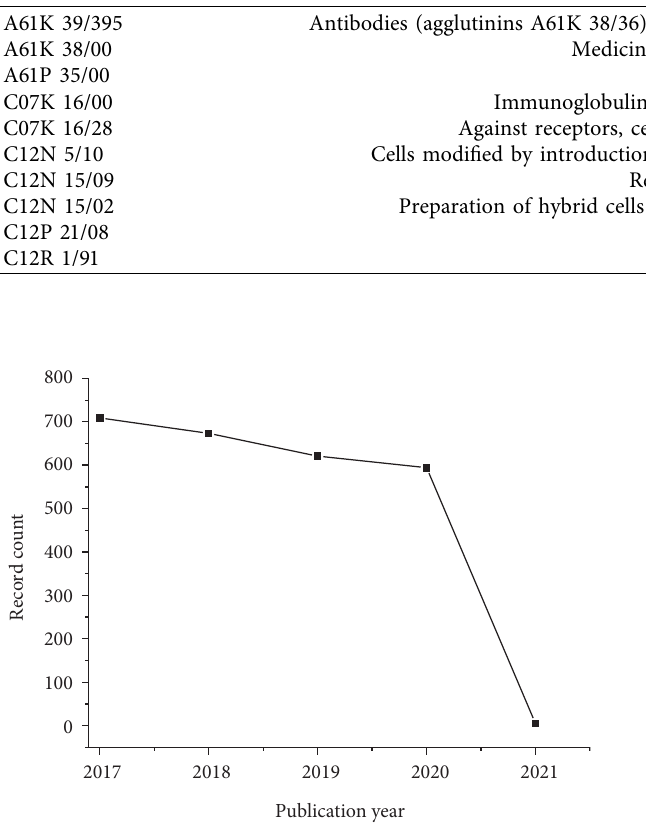
Figure 10: Temporal evolution of articles published in the last 5 years.